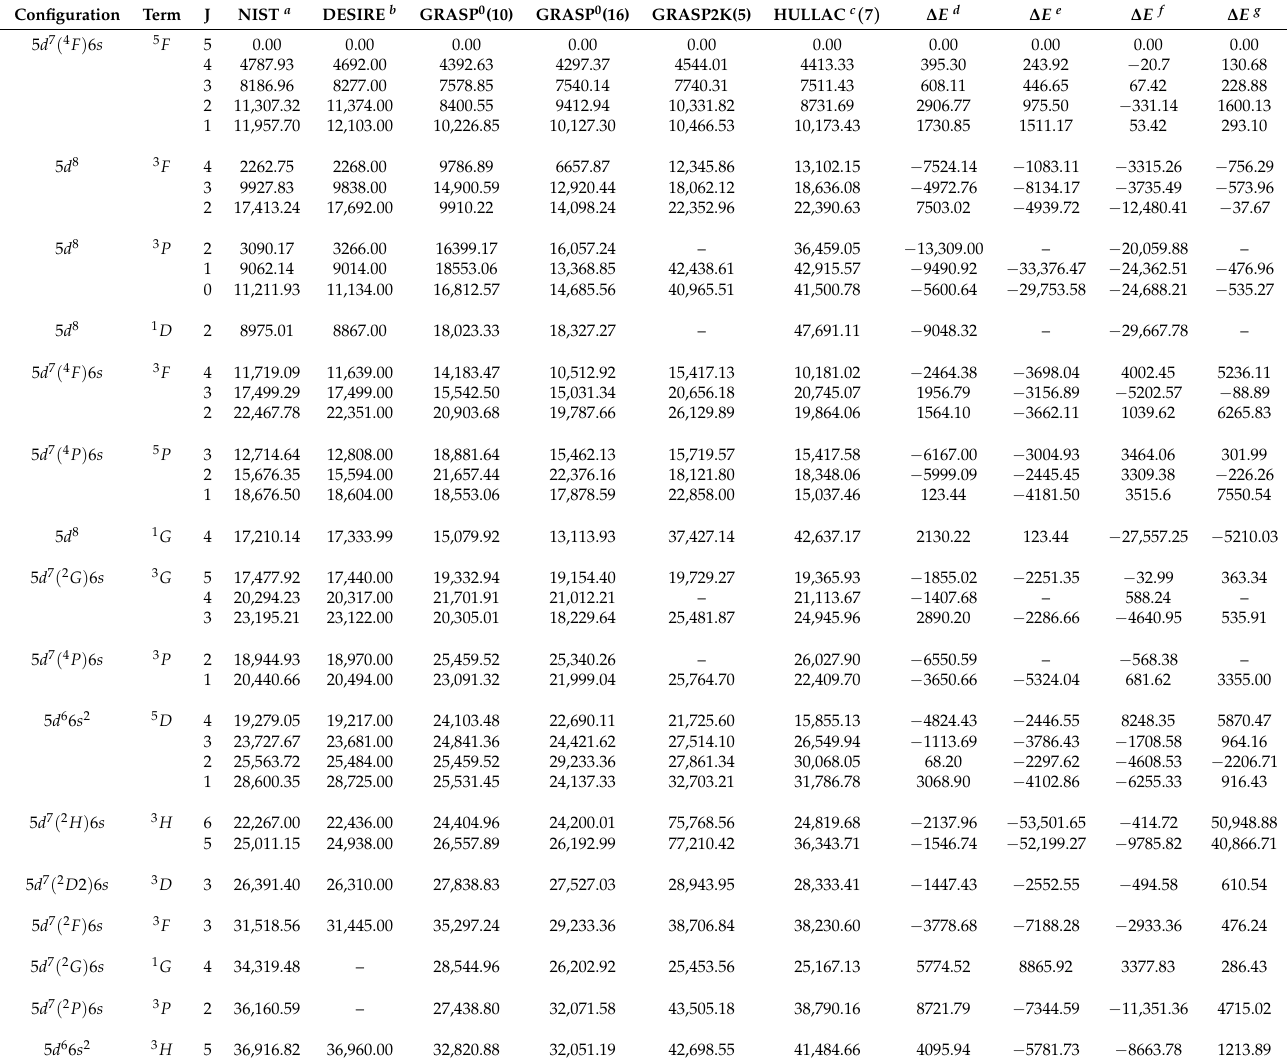
Table 3. Energy levels in cm − 1 for Ir II. The GRASP 0 , GRASP2K, and HULLAC calculations have been performed with configuration numbers given in